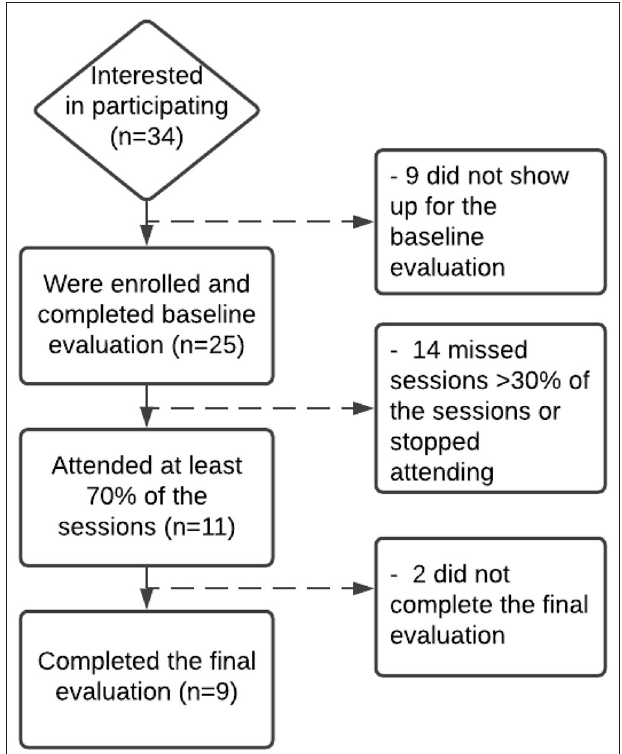
FIGURE 2 | Participant